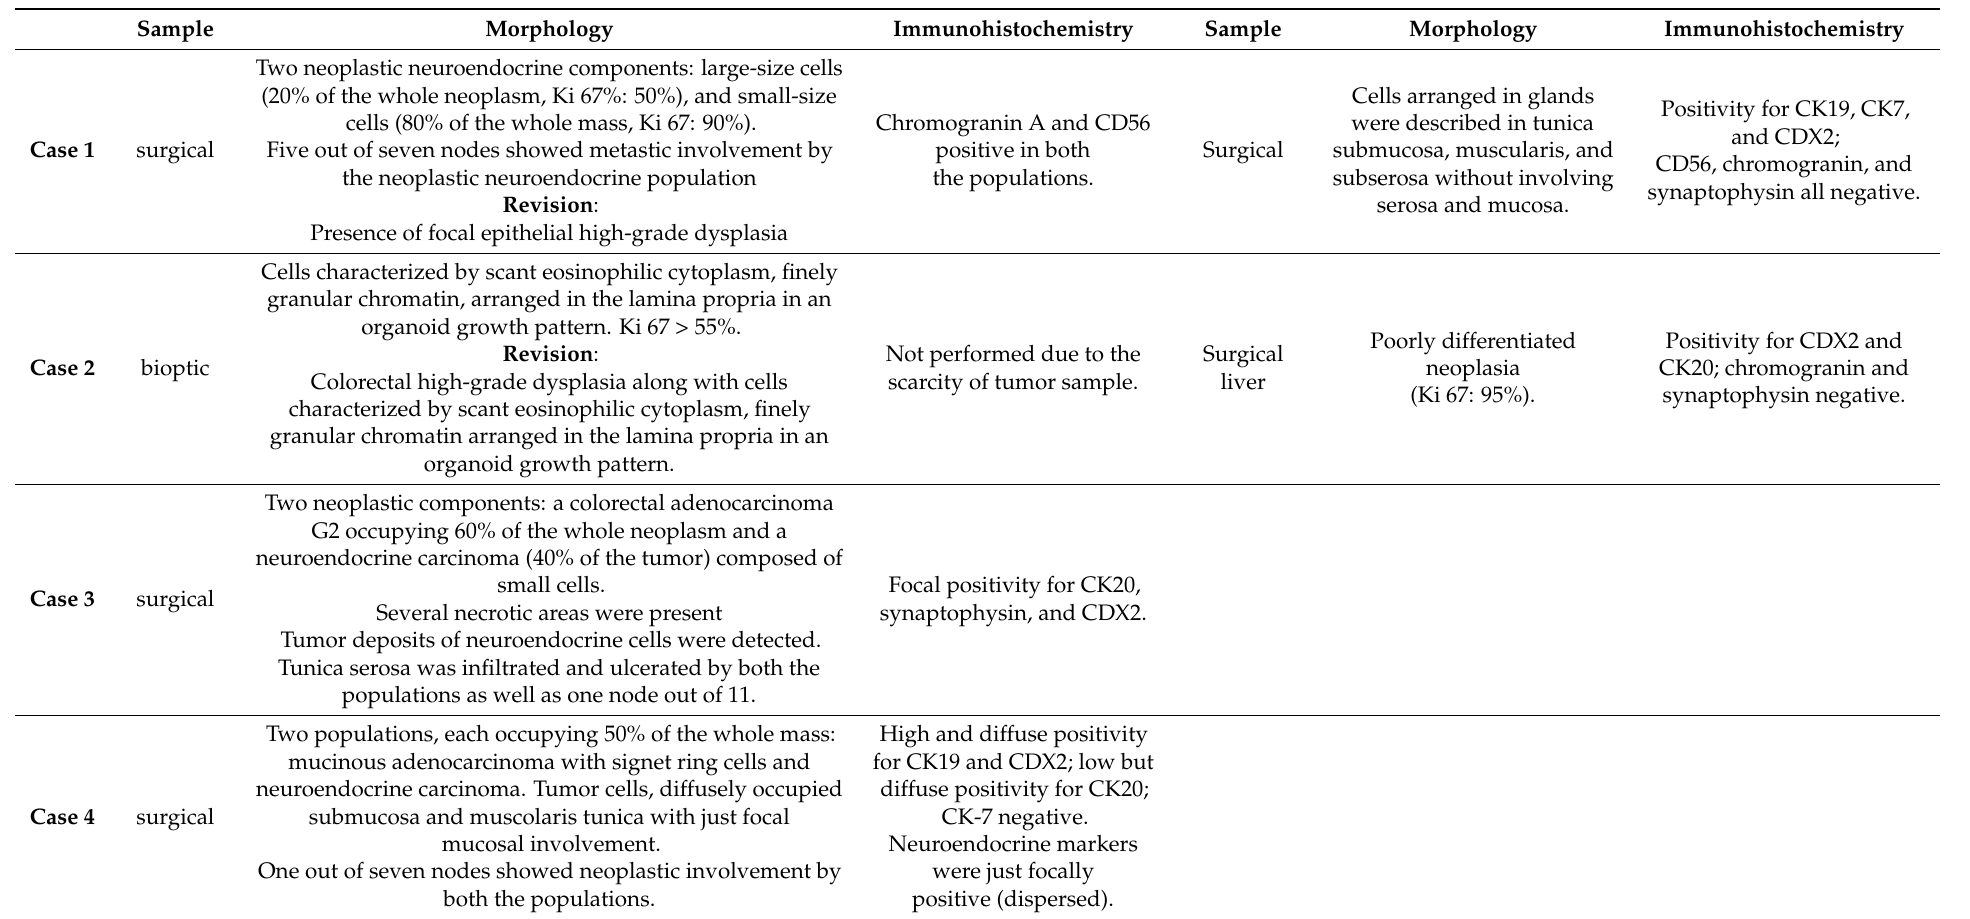
Table 1. Overview of the morphological and immunohistochemical features of all the tumor samples